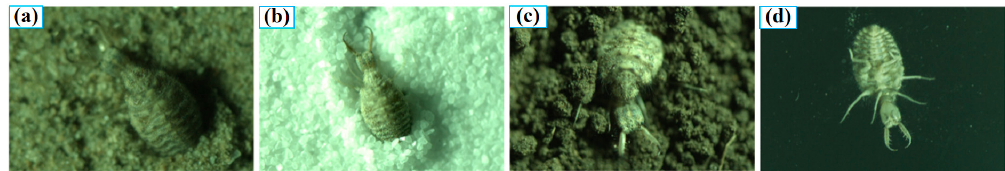
Figure 1. Digging photos of antlions in different conditions: ( a ) Yellow sandy soil; ( b ) White sandy soil; ( c ) Black soil; ( d ) Glass surface.